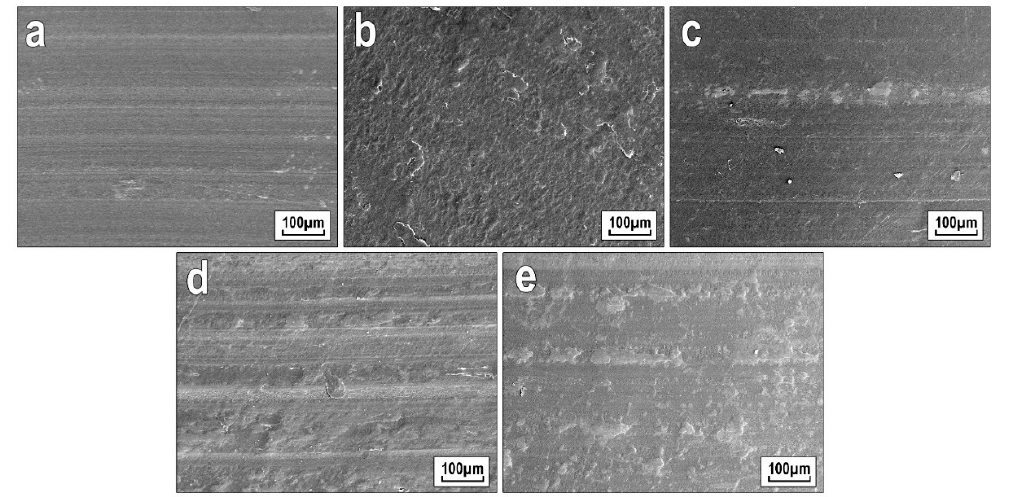
Figure 8. Microphotographs of the friction surfaces of PCM depending on the content of wollastonite, wt.%: ( a ) initial UHMWPE; ( b ) 1; ( c ) 2; ( d ) 10; ( e ) 20.